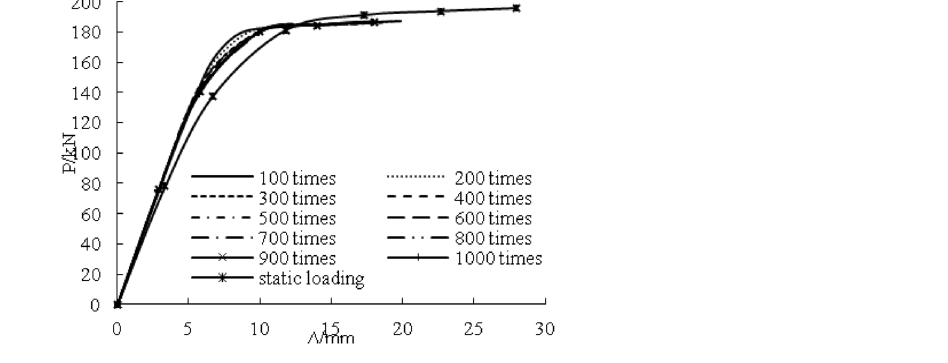
Figure 19. Effect of overloading number.